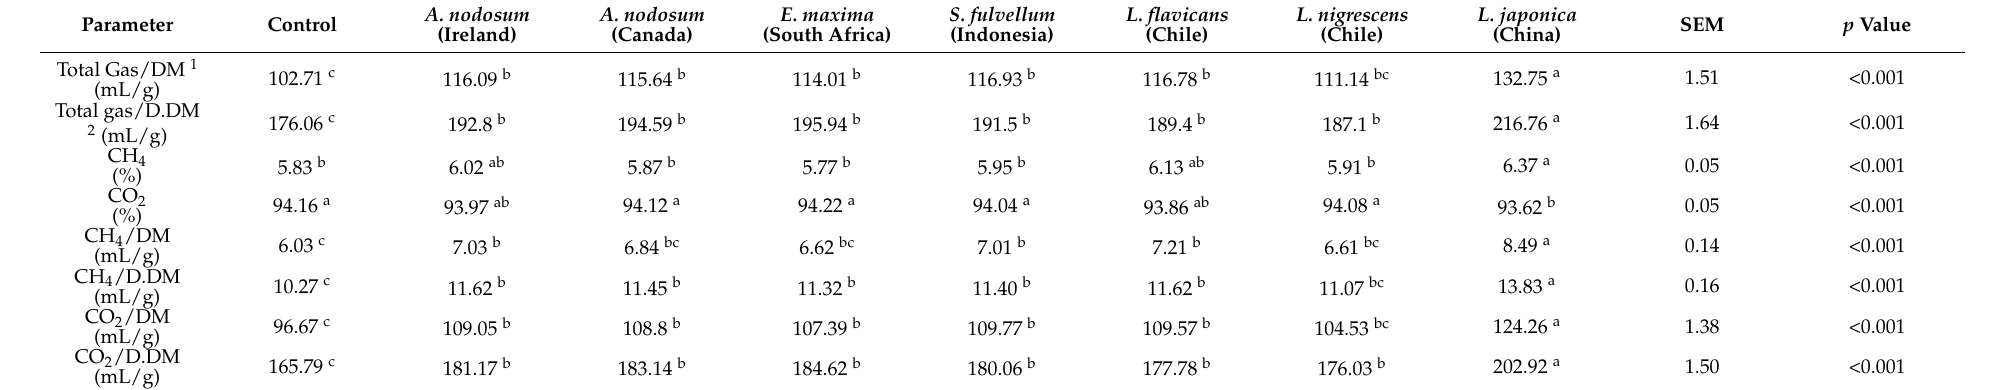
Table 4. Effect of different brown seaweeds as feed additives on gas production profile from 24 h in vitro incubation ( n = 12) (Experiment 1). Parameter